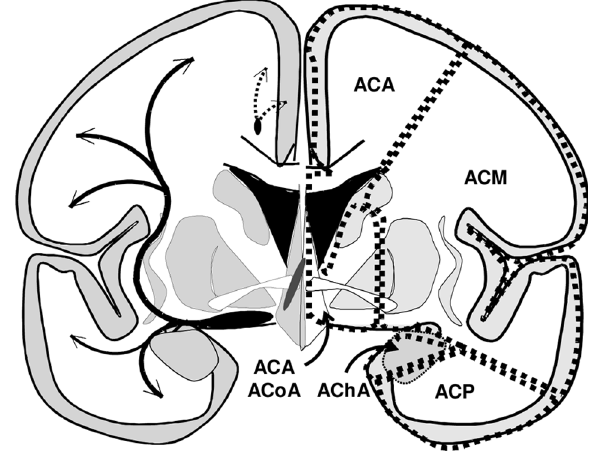
ACA, anterior cerebral artery; MCA, middle cerebral artery; PCA, pos- terior cerebral artery; ACoA, anterior communicating artery; AChA, anterior choroidal artery.